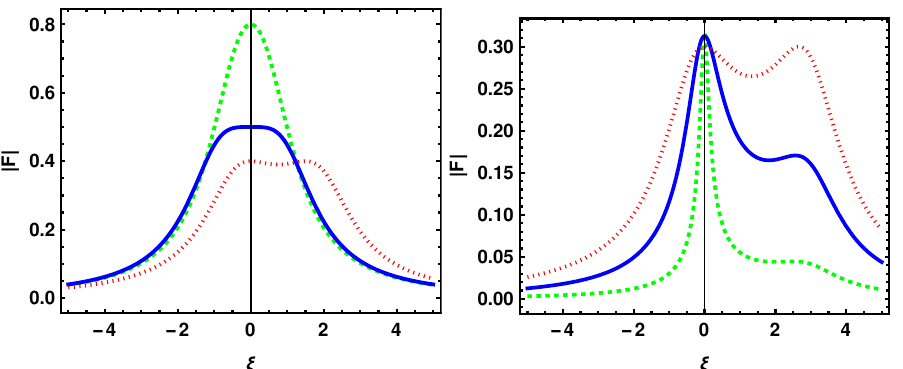
Figure 2. Absolute value of the transfer function F defined by Equation (5), where ω 2 = ω 2 + satisfies (6), γ 1 = 1 and other parameters are varied: ( left ) γ 2 = 1, ω 1 = 1 (dashed), ω 1 = 1 (solid), 2 ω 1 = 2 (dotted); ( right ) ω 1 = 3, γ 2 = 1 (dashed), γ 2 = 1 (solid), γ 2 = 1 (dotted). The corresponding √ 8 2 } , { 0,0, 3 } and { 4 √ } ( left ); {− 0.0047, − 0.07677, − 1 values of ω 2 , β , σ are {− 1 , − 1, − 1 , 2, 5 √ 2 2 4 5 8 √ 2 { 2.66,1.95, 4 } and { 8.58,3.84, 5 } ( right 3 3